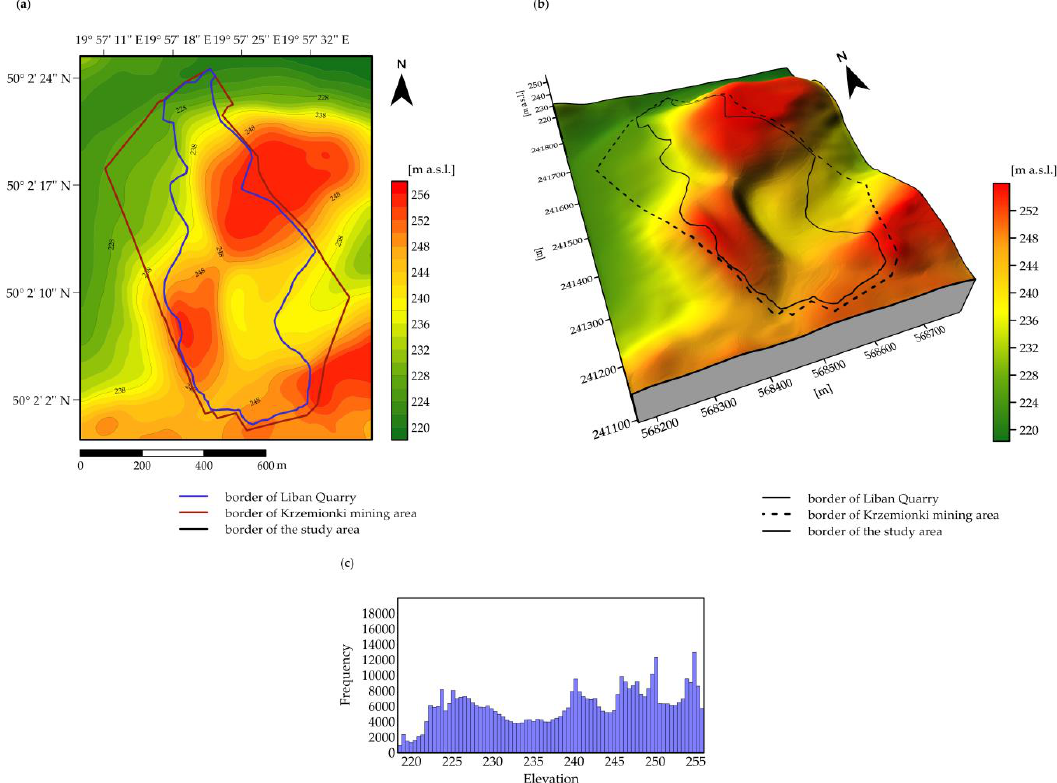
Figure 9. Reconstructed relief of the Krzemionki mining area and its surroundings, obtained by means of ordinary kriging: (a) hypsometric map; (b) DEM; (c) histogram of raster image calculated on the basis of the hypsometric map.